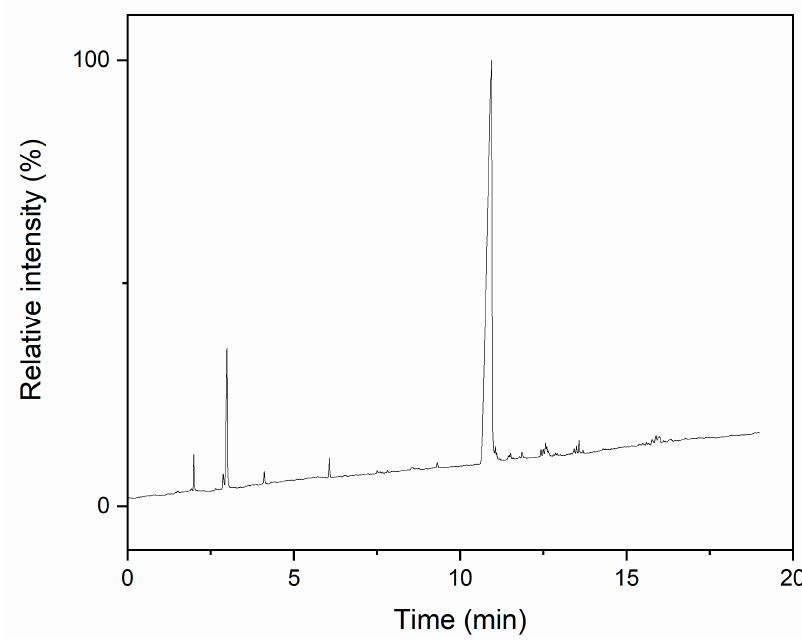
Figure 4. 29 Si NMR spectrum of T 4 M 2.67 Figure 3. GC chromatogram of final product from initial synthesis.